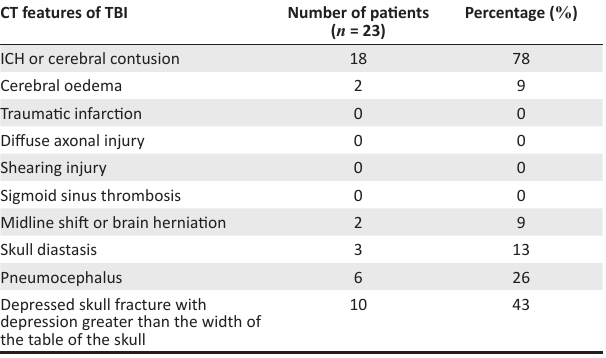
TABLE 1: Computed tomography features of a traumatic brain injury parameters present in patients. CT features of TBI